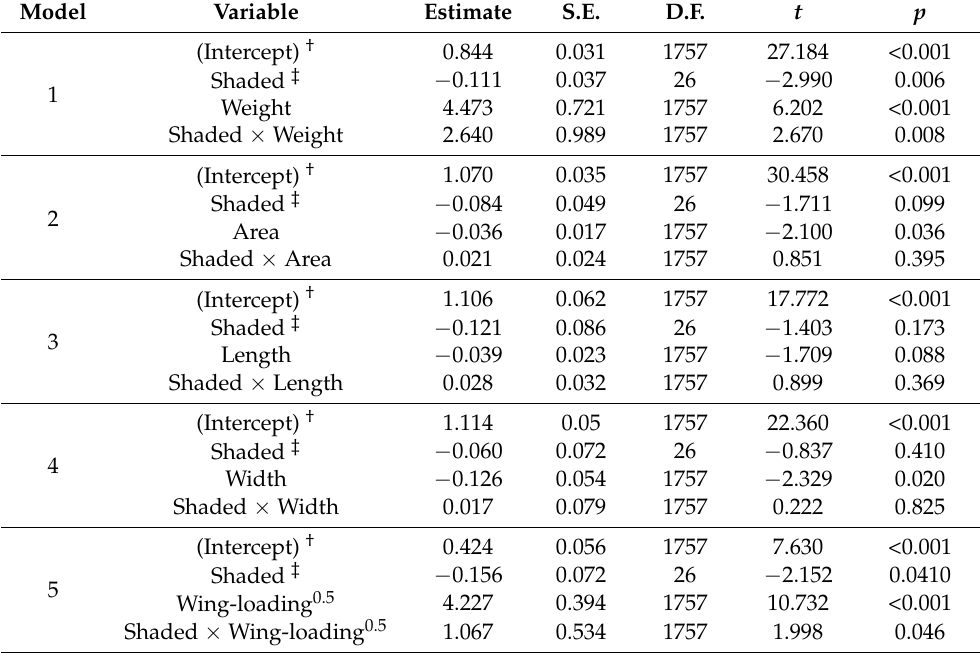
Table 2. Summary statistics (estimate, standard error (S.E.), degree of freedom (D.F.), t -value, p -value) of the nested ANCOVAs (i.e., linear mixed models with microhabitat type, physical property and their interaction term as fixed effects, and site and tree replicate as random effects) on the terminal velocity of